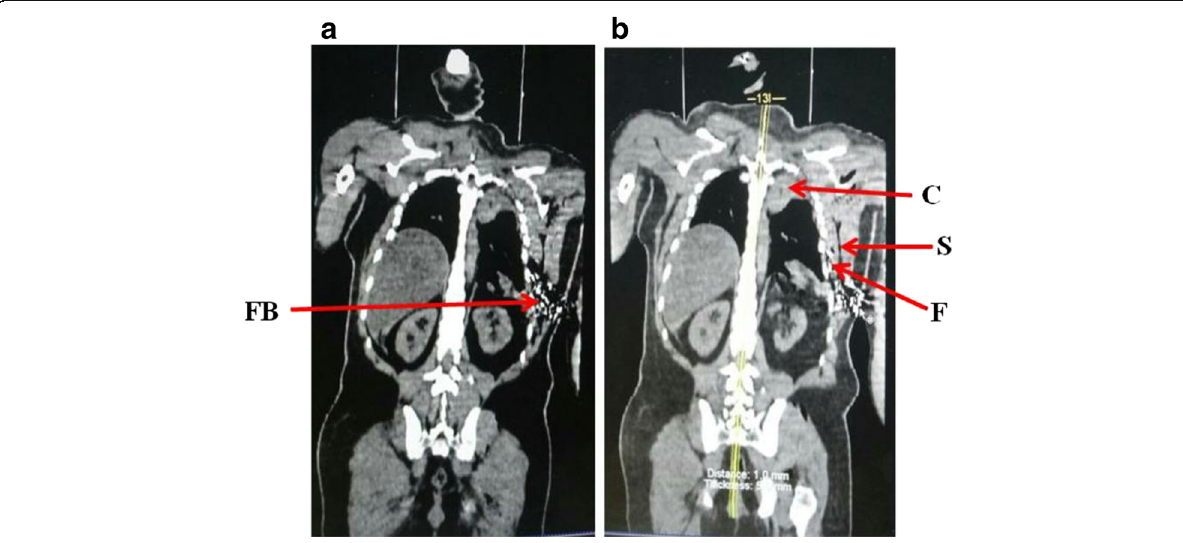
Fig. 5 Multiple gunshot injuries. a PMCT coronal image showing an inlet wound in the middle part of the left side of the chest with multiple small foreign bodies (shots) inside the thoracic cavity (FB). b MDCT coronal image showing laceration of the collapsed left lung, fractures (F) of the left ribs (5th, 6th, and 7th), and subcutaneous surgical emphysema on the opposite side